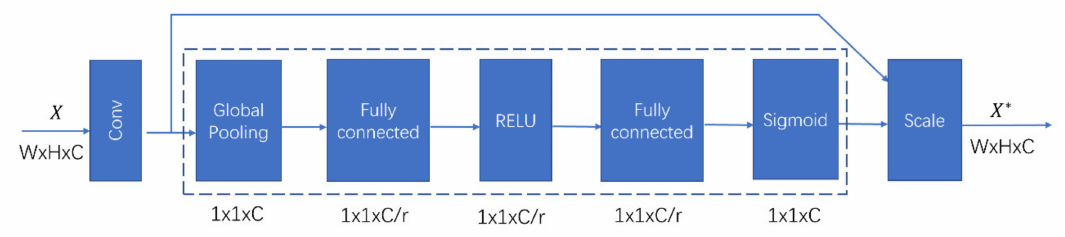
Figure 6. The SE module architecture